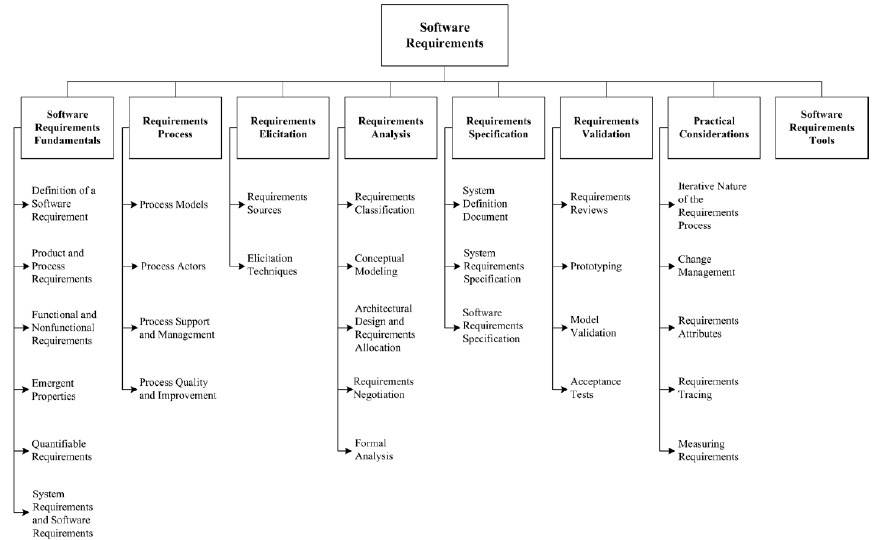
Fig. 1. SWEBOK Chapter 1: Breakdown of Topics for the Software Requirements KA In 2014, IEEE published the Software Engineering Competency Model (SWECOM) [14] which is closely related to and substantially based on SWEBOK. In SWECOM, “Knowledge […] is different from skill: knowledge is what one knows, while skill is what one can do”. This competency model specifies skill areas, skills within skill areas, and work activities for each skill. Activities are specified at five levels of increasing